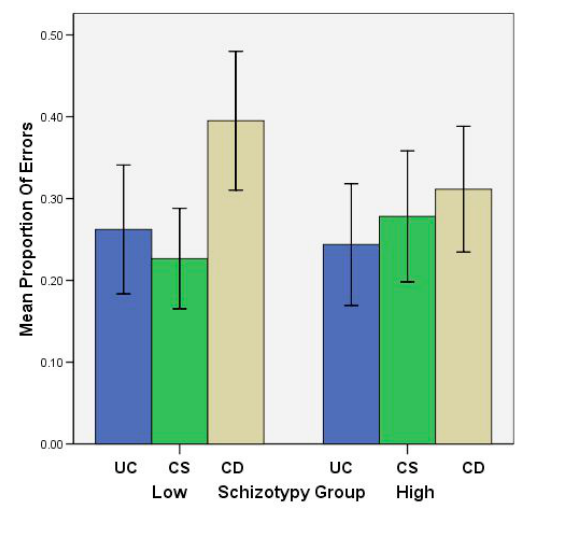
Figure 5. Interaction of trial type and schizotypy.